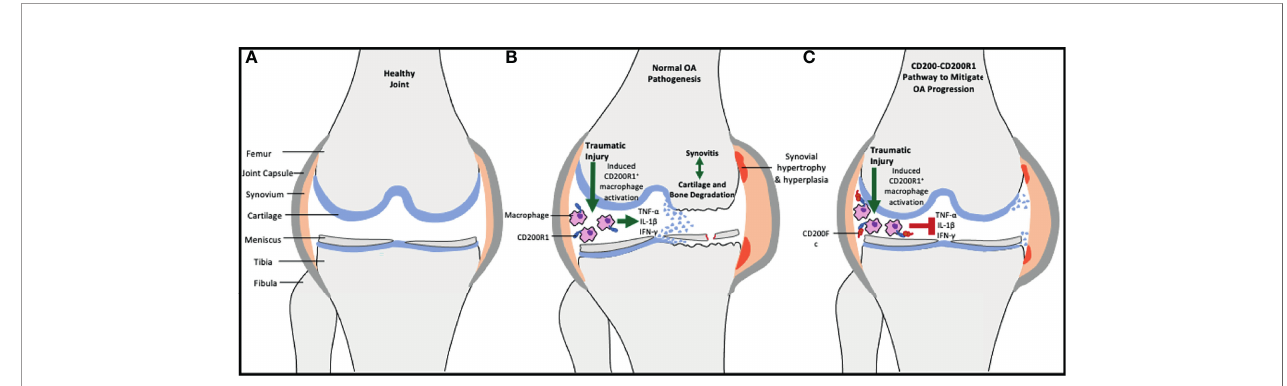
FIGURE 1 | Schematic showing the role of CD200-CD200R1 pathway in osteoarthritis development. (A) demonstrates the anatomic structure of a healthy, non- arthritic joint. (B) In case of knee traumatic injury, a vicious cycle of reparative processes through in fl ammatory activity and structural damage is induced, leading to osteoarthritic changes. CD200R1 expressing macrophages are important mediators of synovitis through secretion of pro-in fl ammatory cytokines. (C) By upregulating CD200 expression (via exogenous CD200Fc or CCS13 aptamer), the CD200R1 positive macrophages are inhibited via the binding of CD200 to the receptor sites, hence leading to downregulation of proin fl ammatory cytokines and disruption of the vicious